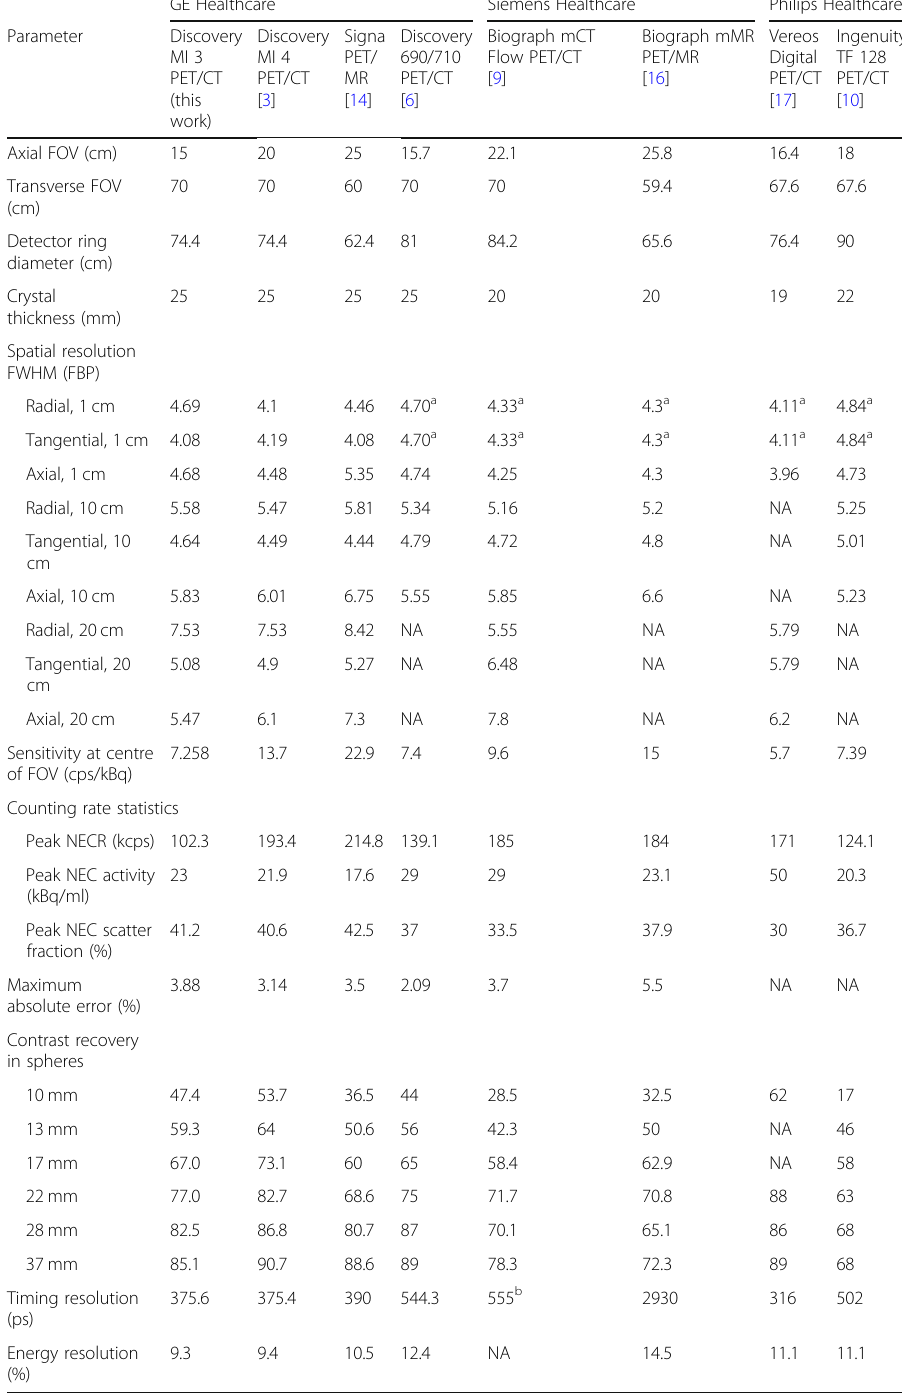
Table 3 NEMA data on PET scanners available on the market GE Healthcare Siemens Healthcare Philips Healthcare Parameter Discovery MI